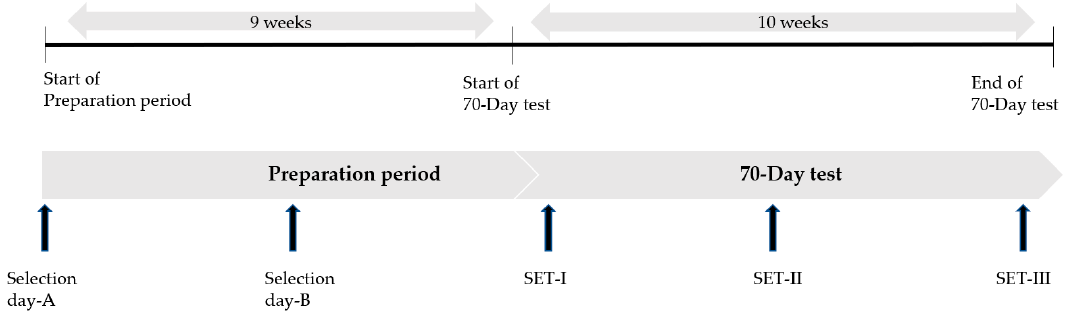
Figure 1. Training schedule of the young Friesian horses during the preparation period and the 70- 70-day test, including standardized exercise tests day test, including standardized exercise tests (SET).